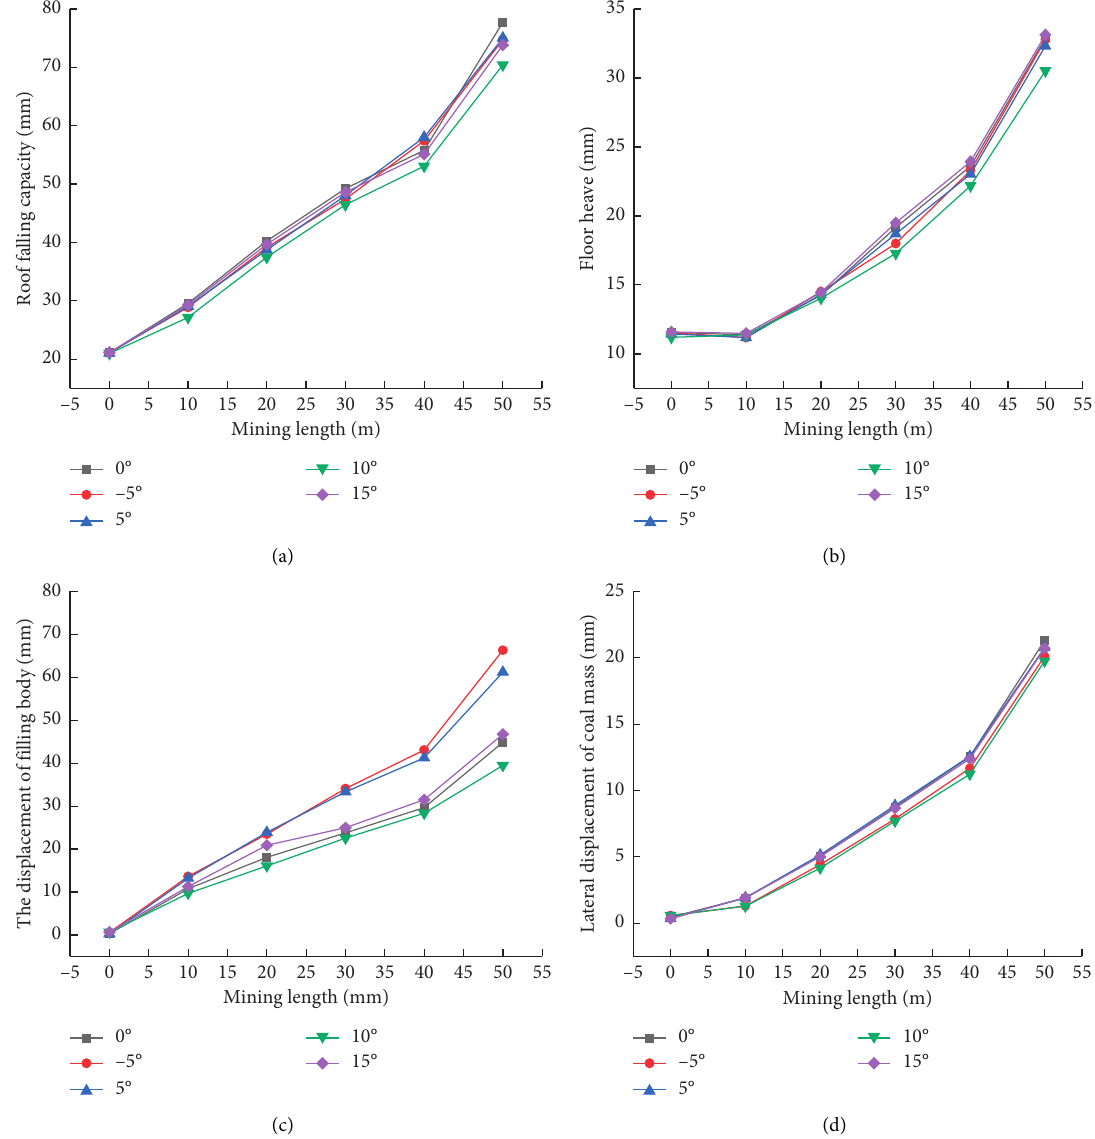
Figure 4: Variation of surrounding rock deformation of roadway: (a) roof subsidence curve; (b) curve of floor heave; (c) displacement of filling wall; (d) coal body convergence